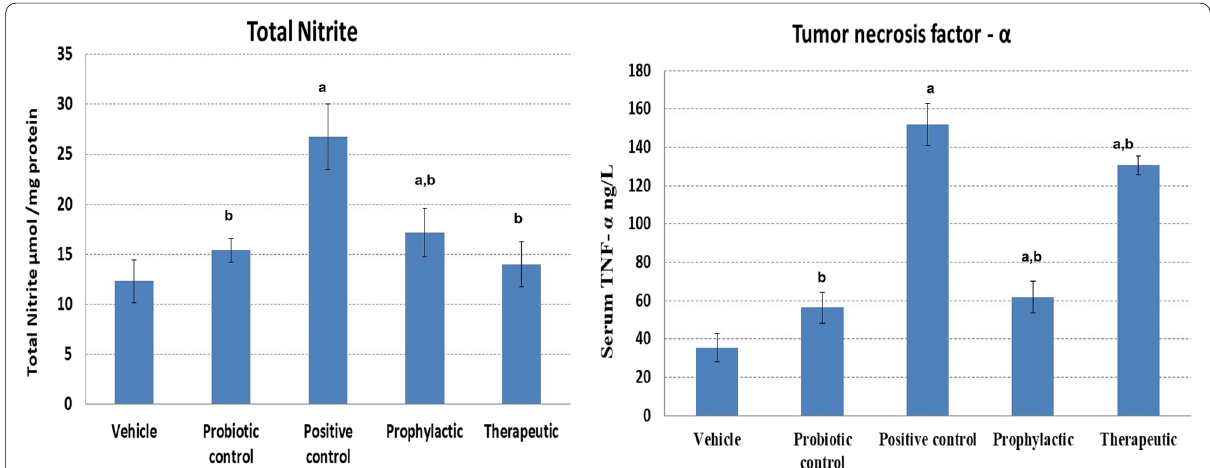
Fig. 3 The modulatory effect of probiotic LGG administration on inflammatory markers. Total nitrite in liver homogenate (µmol/mg protein) and serum tumor necrosis factor‑α (ng/ml) were measured in the different studied groups. Data presented as mean to the vehicle group. b Significant p < 0.05 compared to positive